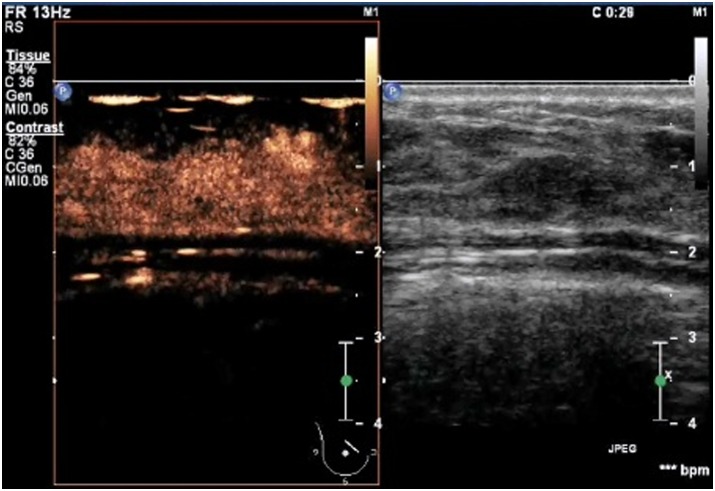
A lesion with a score of 2 by breast contrast-enhanced ultrasound.The lesion displayed iso- and synchronous enhancement with the surrounding tissue, without a clear outline in the contrast-enhanced image.